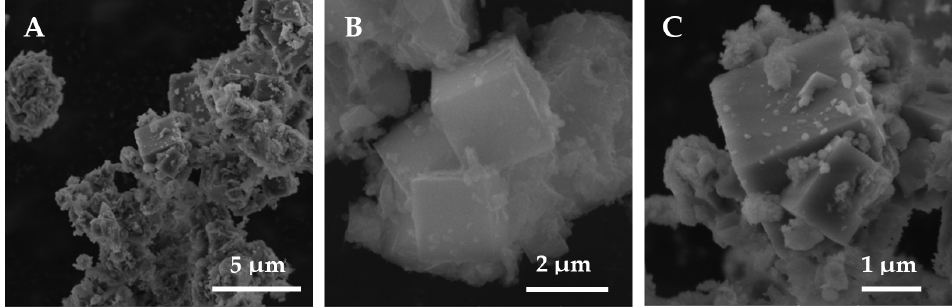
Figure 8. Micrograph of the LTA C 6 h samples: ( A ) 5 µm scale, ( B ) 2 µm scale, and ( C ) 1 µm scale.